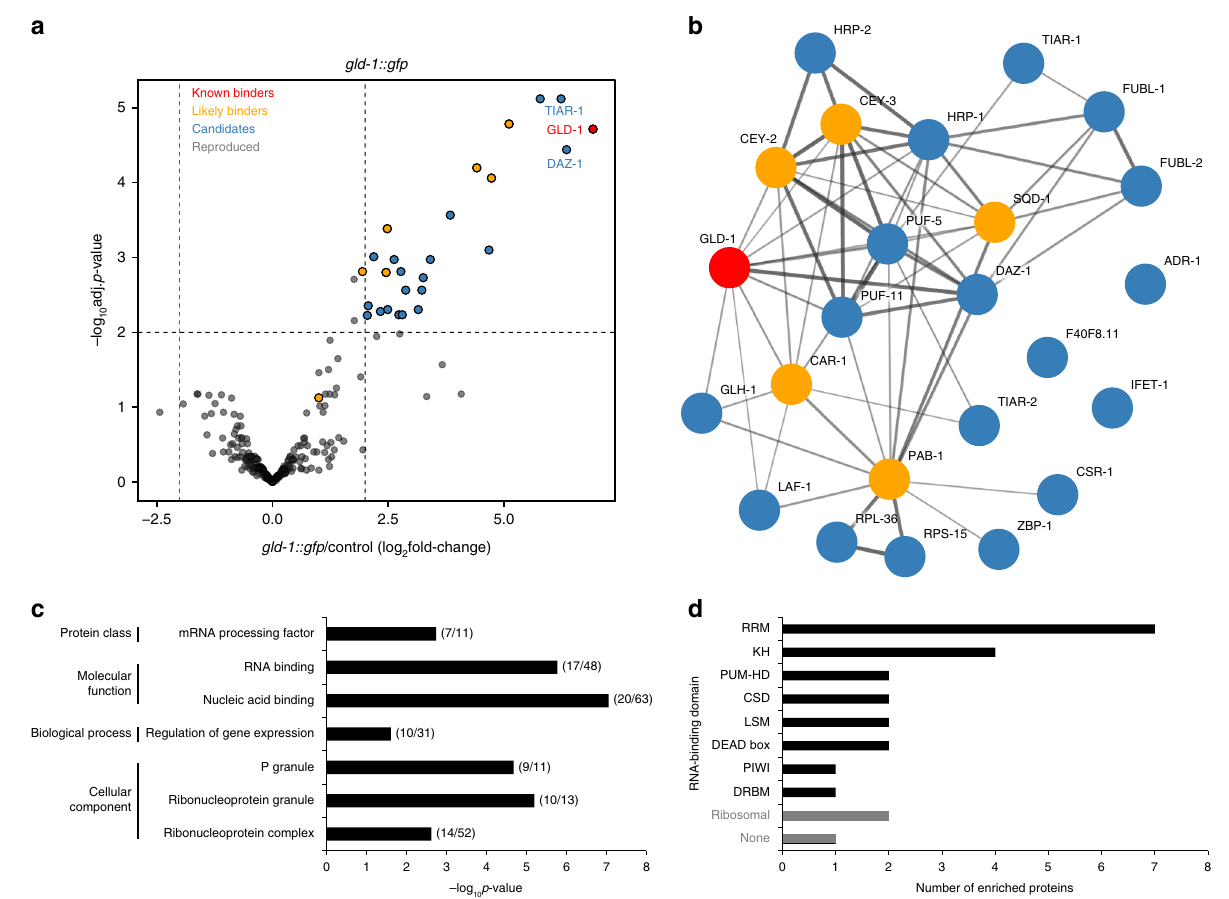
Fig. 3 vIPR of gld-1::gfp reproducibly enriches for RBPs that are functionally linked. a Triplicate vIPR of gld-1::gfp identi fi es proteins that reproducibly enrich versus no-target control. Proteins reproducibly detected: n = 273, proteins reproducibly enriched: n = 25 (24 endogenous C. elegans proteins plus GFP). Mean fold-changes and p -values (moderated t -test; BH-corrected; Supplementary Data 3) from three independent pulldown experiments are